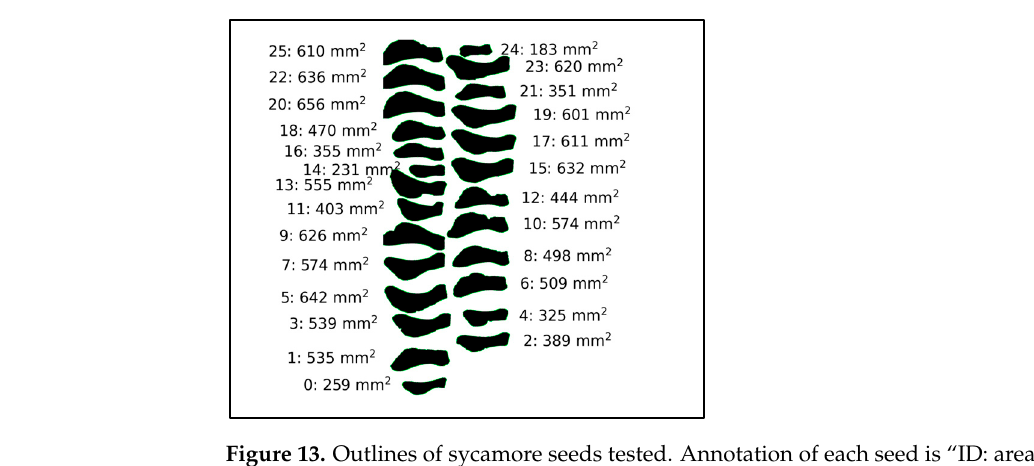
Figure 13. Outlines of sycamore seeds tested. Annotation of each seed is “ID: area (mm²)”. Table 2. Sycamore seed results. Mass, time to fall 2 m, average speed falling 2 m, surface area and intrinsic component. ID denotes the order in which the seed where dropped.